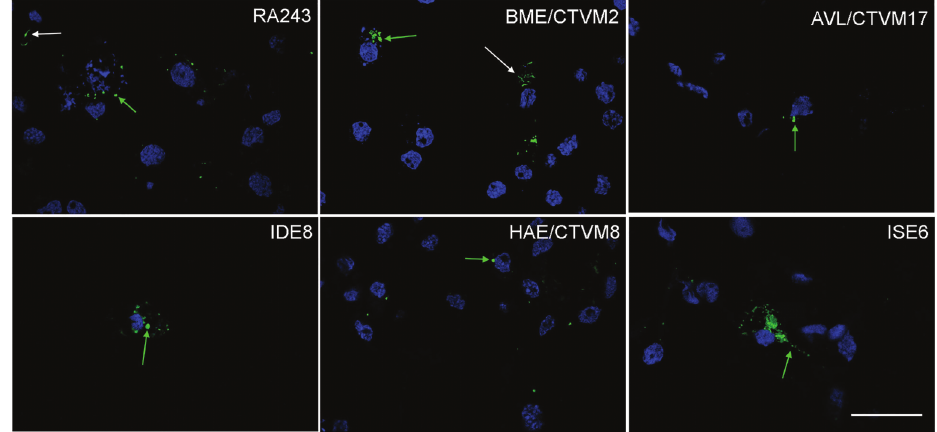
Figure 5. Confocal optical slices of tick cell lines 24 h after inoculation with PKH67-stained Borrelia burgdorferi. Internalization was performed in 10% BSK-H + 90% cell medium in cell lines RA243, BME/ CTVM2, AVL/CTVM17, IDE8, HAE/CTVM8 and ISE6, as indicated. Extracellular and internalized B. burgdorferi are indicated by white and green arrows, respectively. Representative stacked images were taken at a de fi ned cross-section of the tick cells as close as possible to the center of the cell. The scale bar represents 50 m